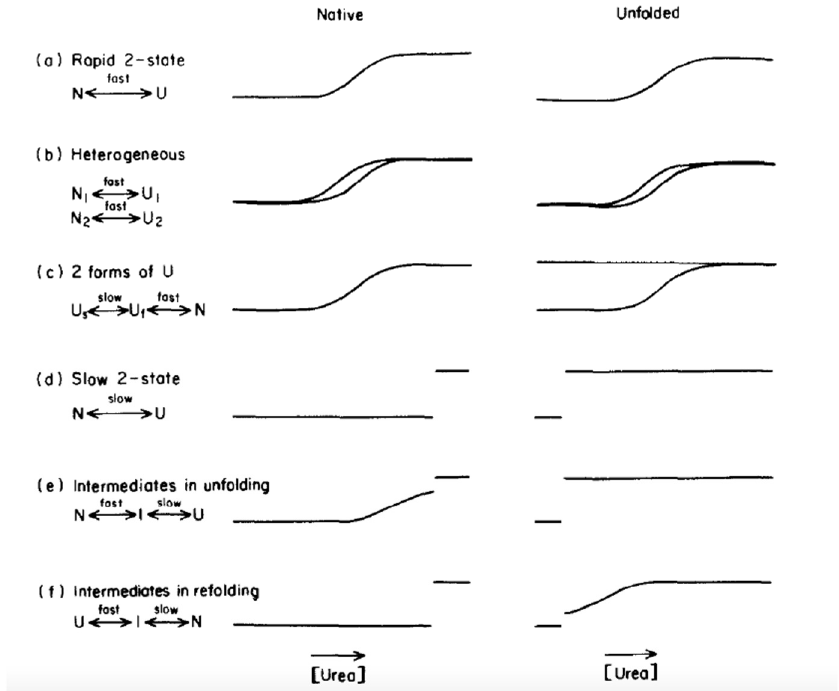
Figure 7. TUGGE patterns for most unfolding and refolding transitions. Left panel: unfolding transitions of native proteins; right panel: refolding transitions of the same proteins previously fully unfolded and applied to the top of the gel (reproduced from [185] with permission from Elsevier). ( a ) Unfolding and refolding processes obey the two-state model: rapid transition between N and U states; ( b ) the native state (N) is heterogeneous, each population unfolds and refolds rapidly at different denaturant concentrations; ( c ) two slowly interconverted unfolded states exist, one refolds rapidly, the second one refolds slowly; ( d ) unfolding and refolding are slow processes, so the initial state, N or U, persists in denaturing/non-denaturing conditions; ( e ) rapid and reversible partial unfolding produces a stable intermediate (I) prior to complete unfolding; ( f ) this case is opposite to ( e ), with the production of a stable refolding intermediate